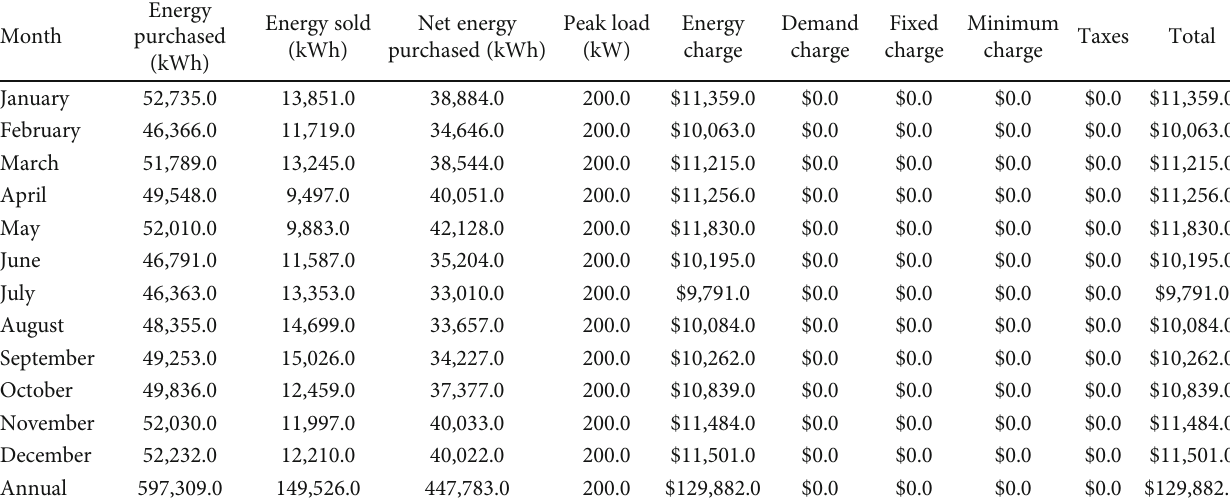
Table 28: Utility monthly summary — proposed system (Rwanda).